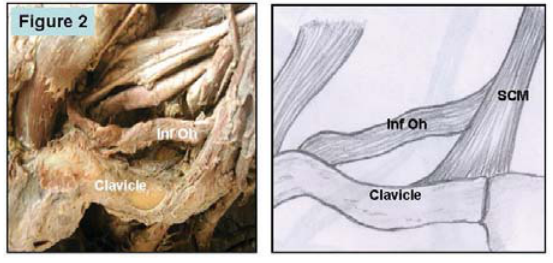
Figure 2 - Dissection of right cervical region showing inferior belly omohyoid from the Clavicle: SCM - Sternocleidomastoid; Inf Oh - Inferior belly of Omohyoid